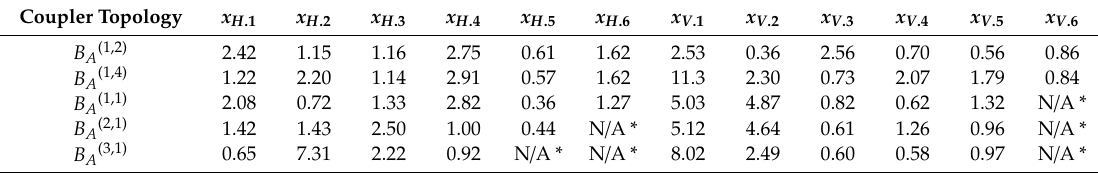
Table 3. Dimensions of couplers featuring acceptable performance.